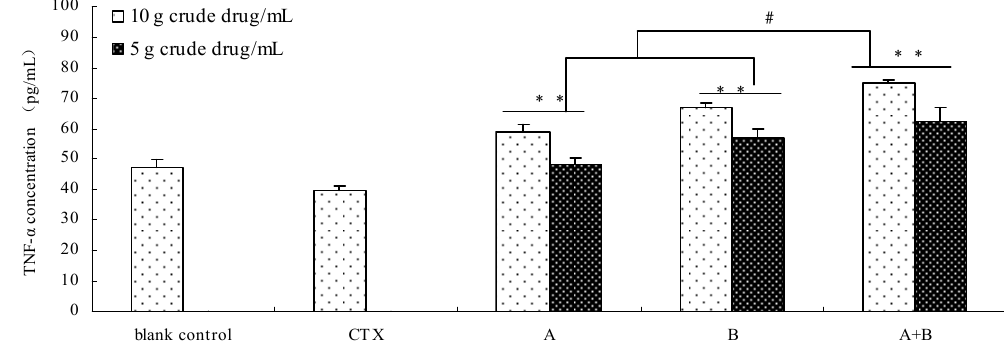
Figure 10. Effect of components and components combination on TNF- α content in serum of tumor-bearing